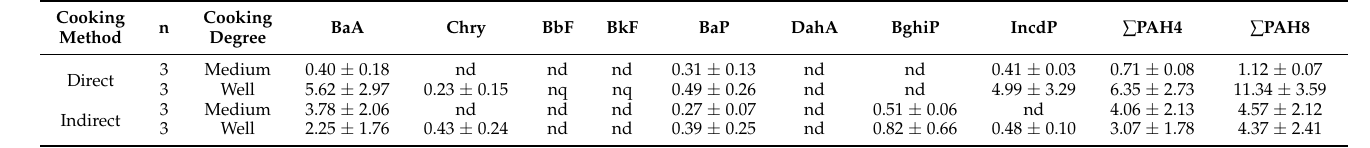
Table 2. The individual PAH contents (ng/g) of the samples cooked using direct and indirect cooking methods at different cooking degrees (mean ±